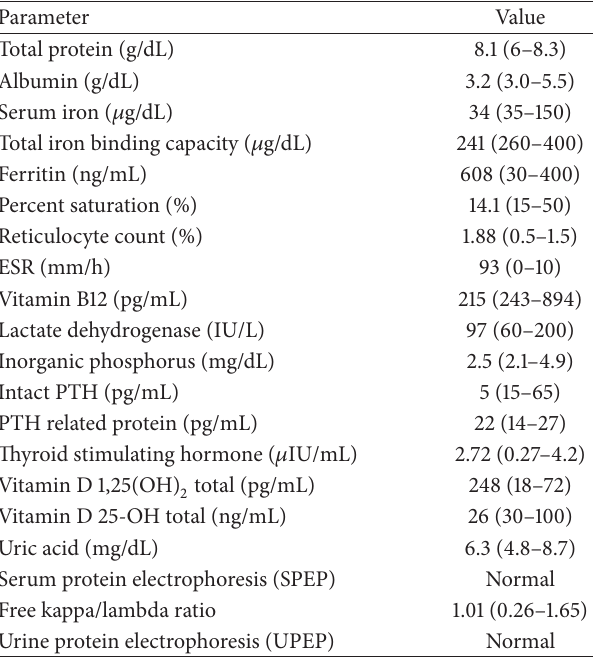
Table 1: Laboratory